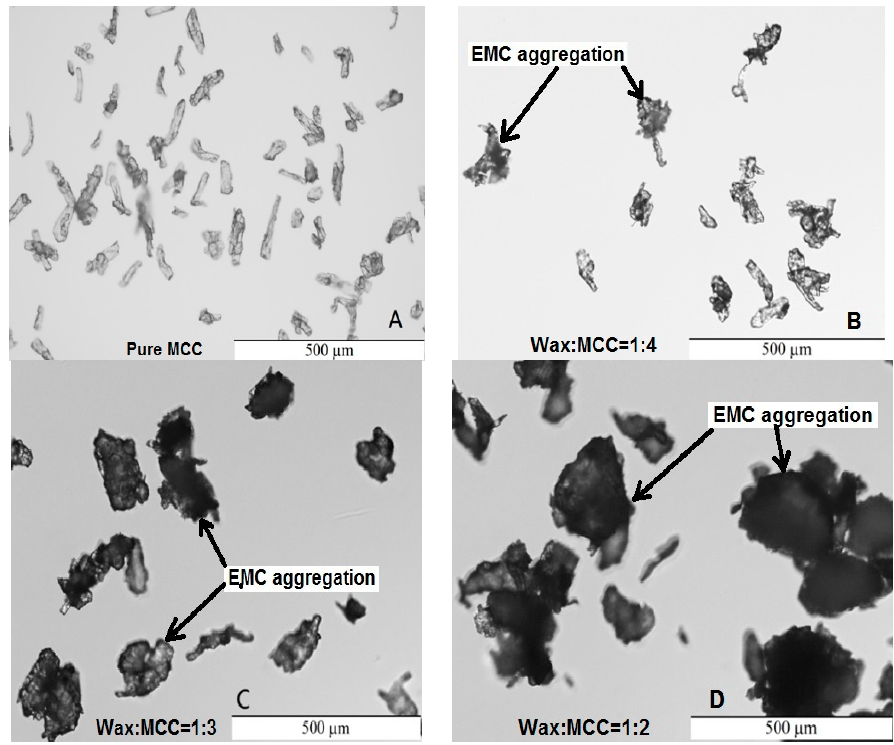
Figure 2. Differential interference contrast (DIC) micrographs of MCC ( A ); and EMC with wax:MCC